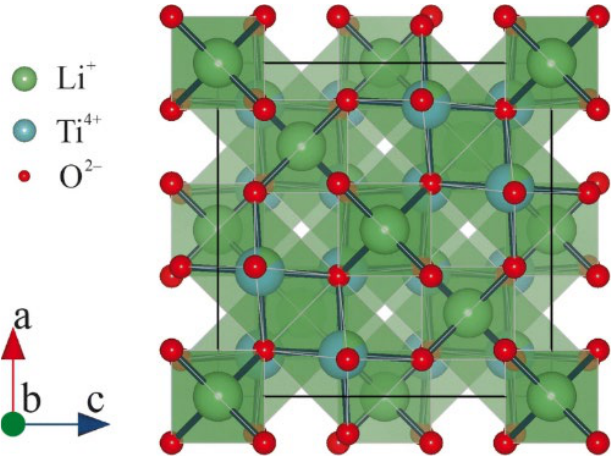
Figure 4. Crystal structures of Li 4 Ti 5 O 2.